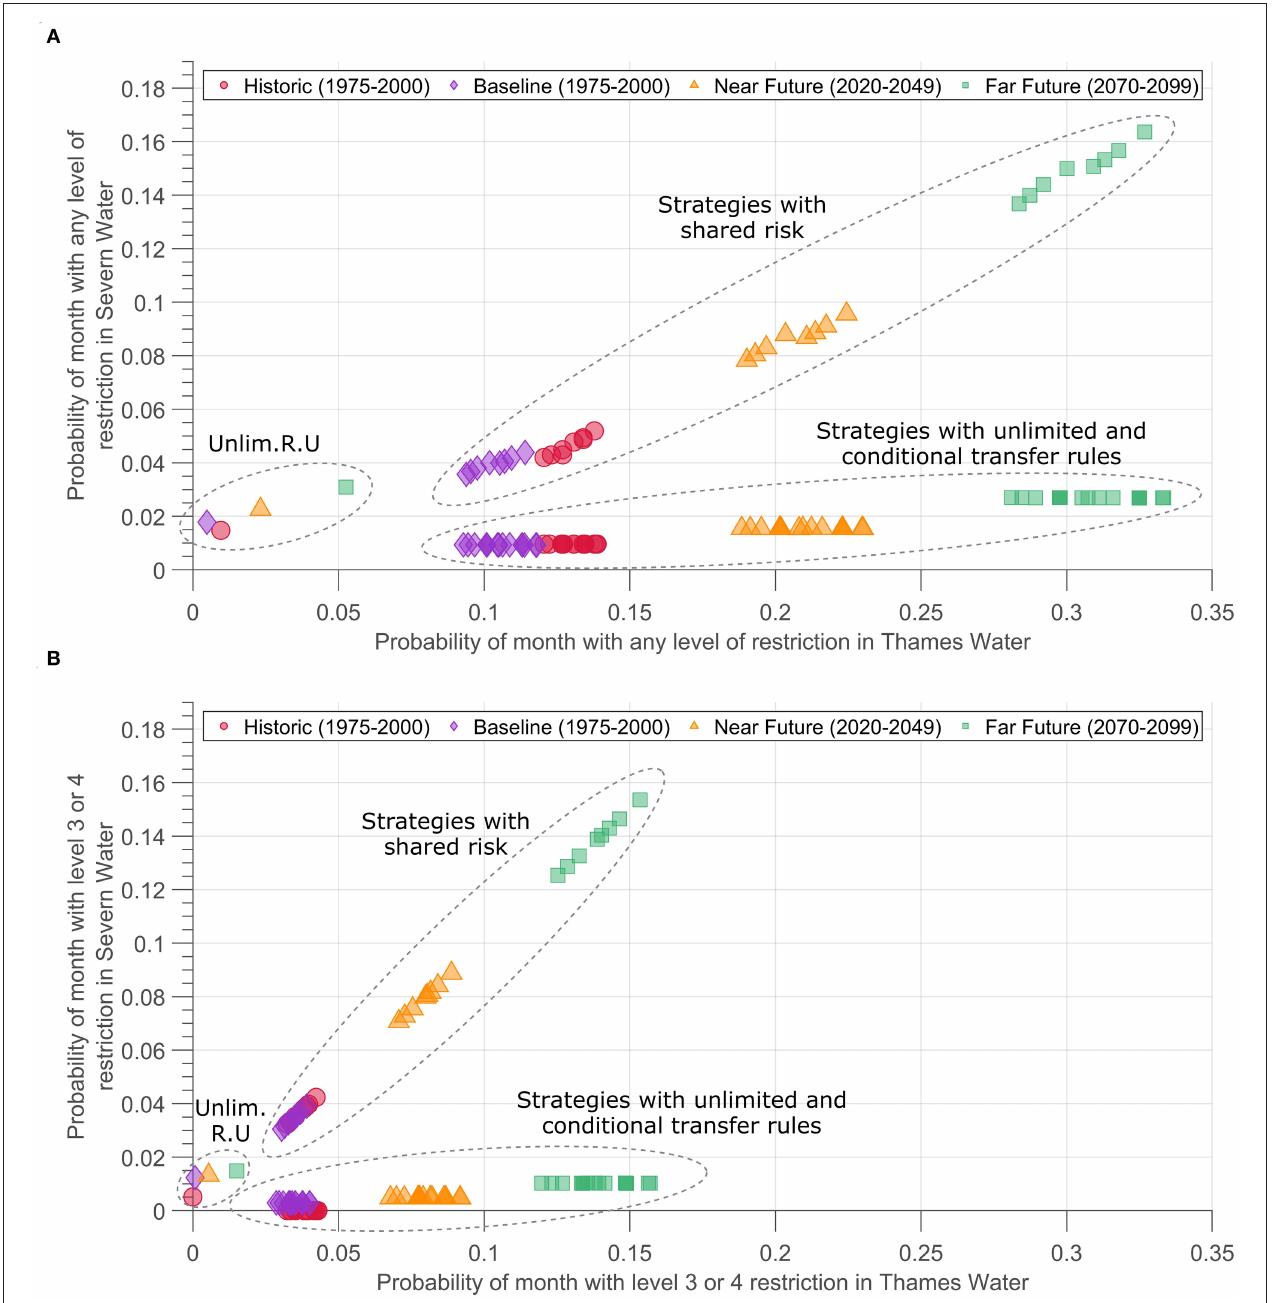
FIGURE 5 | Probability of Thames and Severn experiencing any level of water restriction (A) and severe / level 3 and level 4 water restrictions (B) in any given month for each infrastructure strategy in Historic (circular markers, red), Baseline (diamond markers, purple), Near Future (triangular markers, orange), and Far Future (square markers,